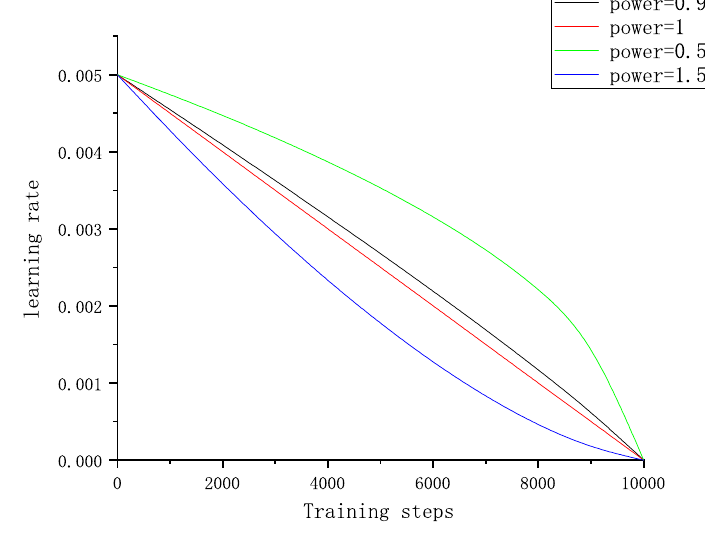
Figure 8. Changes in learning rate(LR) under different power